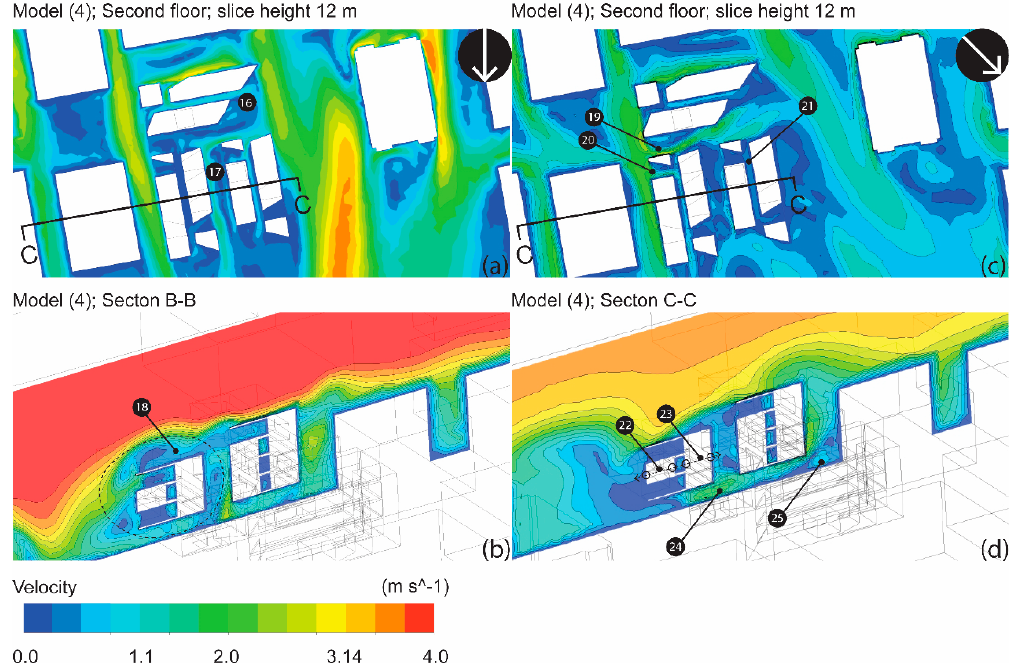
Figure 6. ( a , b ) Roof surface development at lower wind velocity; ( c , d ) air flow characteristics by wind flowing from the northwest.